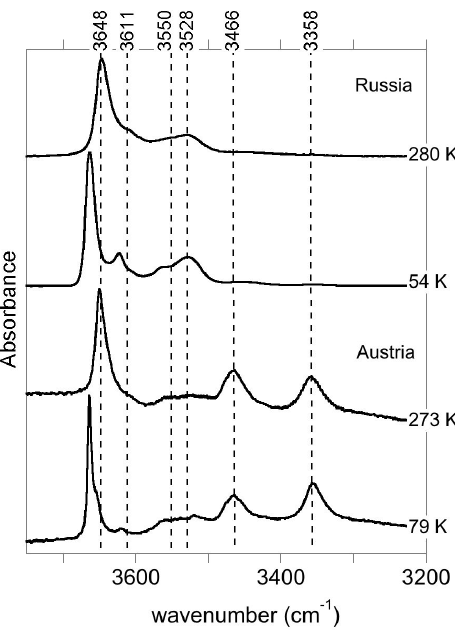
Figure 1. Infrared absorption spectra of Russian and Austrian diop- side samples recorded at near-ambient and low temperatures. Note the significant positive shift and narrowing of the bands observed at frequencies above 3600cm − 1